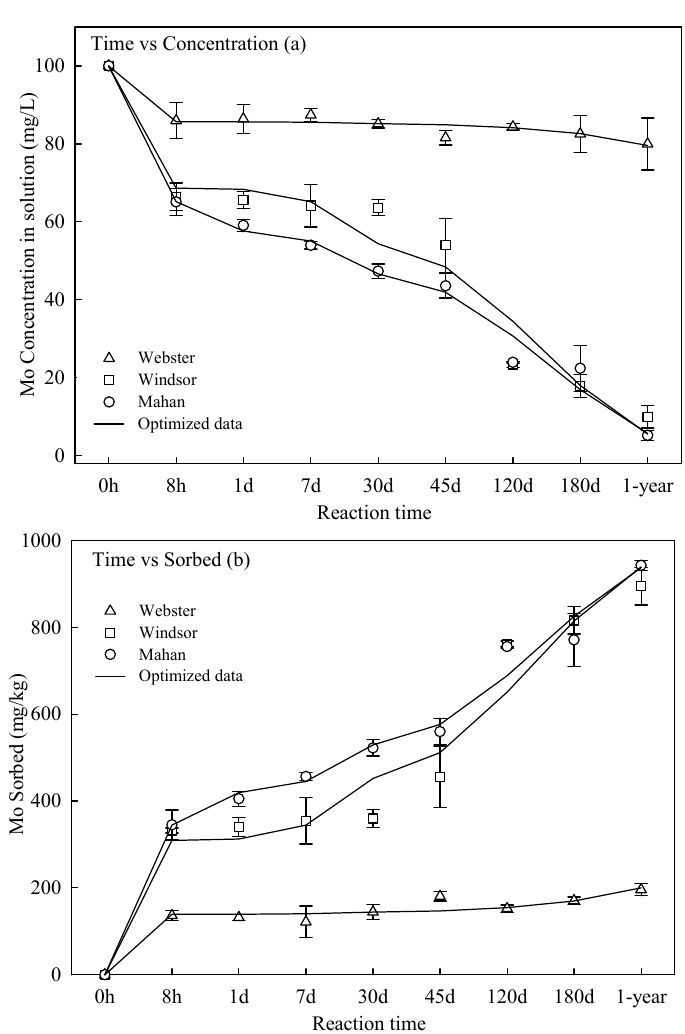
Figure 2. Adsorption kinetics of molybdenum (VI) in Mahan, Windsor, and Webster soils. ( a ) Molybdenum (VI) concentration in solution as a function of reaction time during adsorption process; ( b ) molybdenum (VI) sorbed as a function of reaction time during adsorption process.